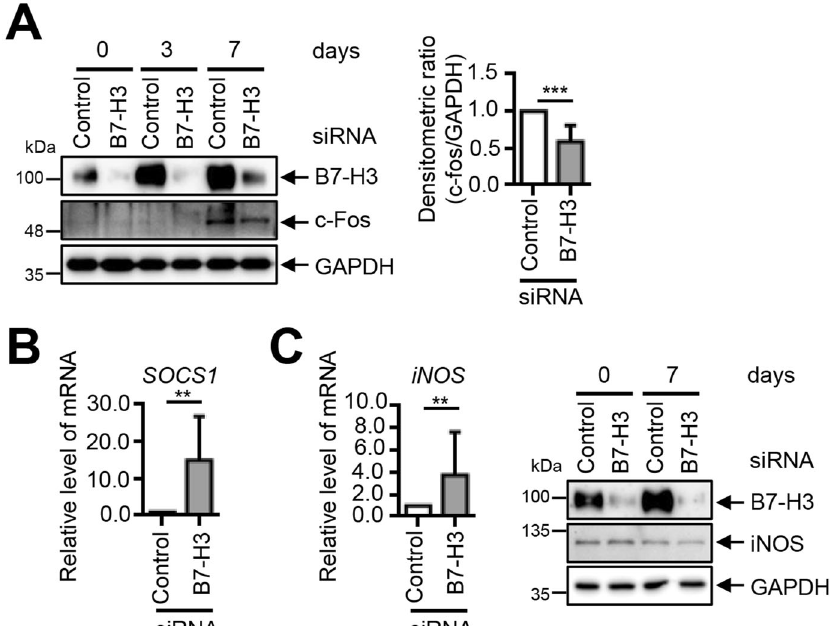
Fig. 5 B7 – H3 de fi ciency-mediated type-I IFN-dependent osteoclastogenesis inhibition is independent of c-Fos, iNOS, and SOCS1. A , B M-CSF (40 ng/ml) was added to monocyte culture for three days. OCPs that were transiently transfected with B7 – H3-speci fi c siRNA or control siRNA (40 nM) were induced to differentiate using M-CSF (40 ng/ml) and RANKL (80 ng/ml) for seven days. The expression of B7 – H3, c-Fos and iNOS protein during osteoclast differentiation was detected via Western blot. The bar graphs show the densitometry analyses of the gels depicted relative to the internal control at day 7 of differentiation. B , C OCPs were transiently transfected with B7 – H3-speci fi c siRNA or control siRNA (40 nM) for one day. The expression of SOCS1 and iNOS mRNA was analyzed using RT-qPCR. The mRNA levels were normalized relative to GAPDH